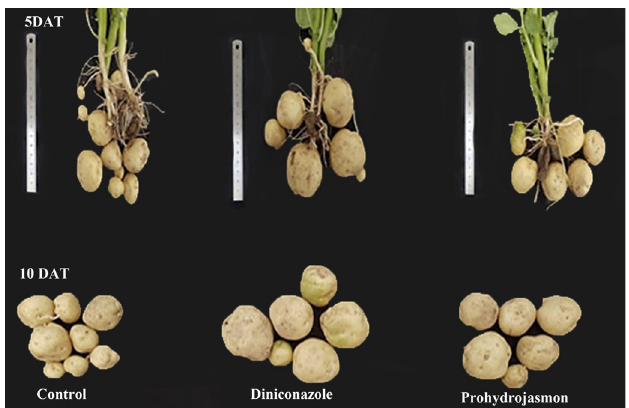
Supplementary Fig. 2: phenotypical visualization of potato tuber average weight after 5 and 10 days of DIN and PDJ